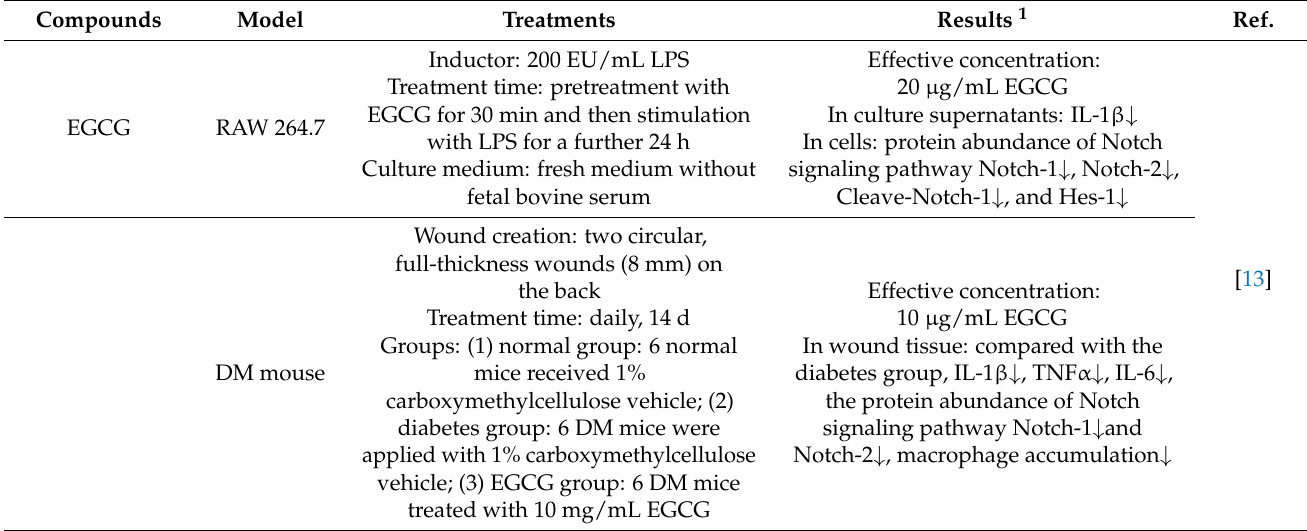
Table 2. The anti-inflammatory and angiogenic effects of EGCG and its wound dressings. Compounds Model Treatments Results 1 Ref.